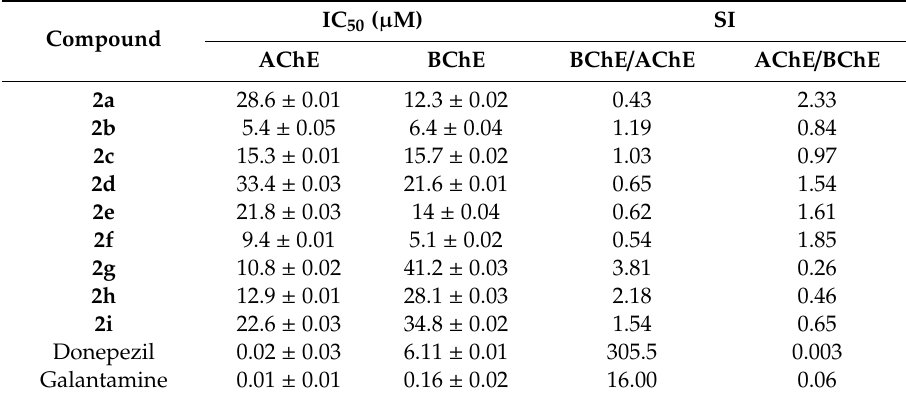
Table 2. AChE and BChE inhibitory activities of compounds 2a – i